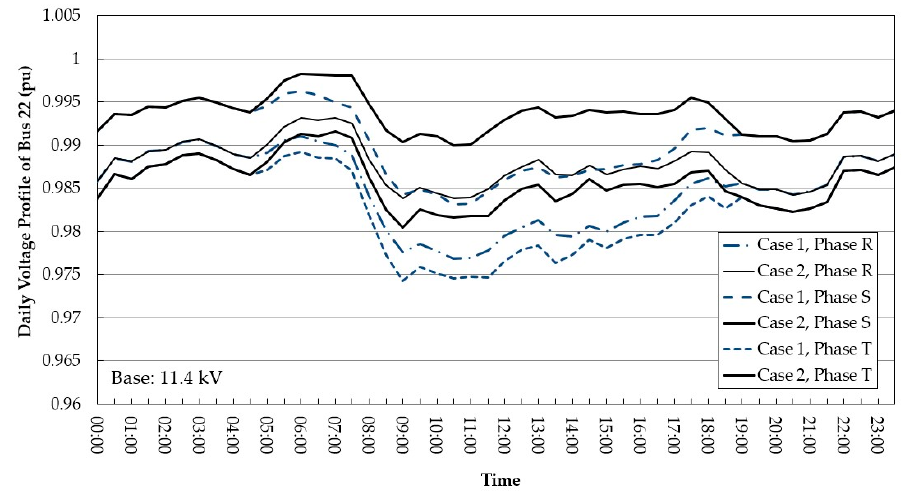
Figure 14. Voltage variation comparison on Bus 1 for Case 1 and Case 2.